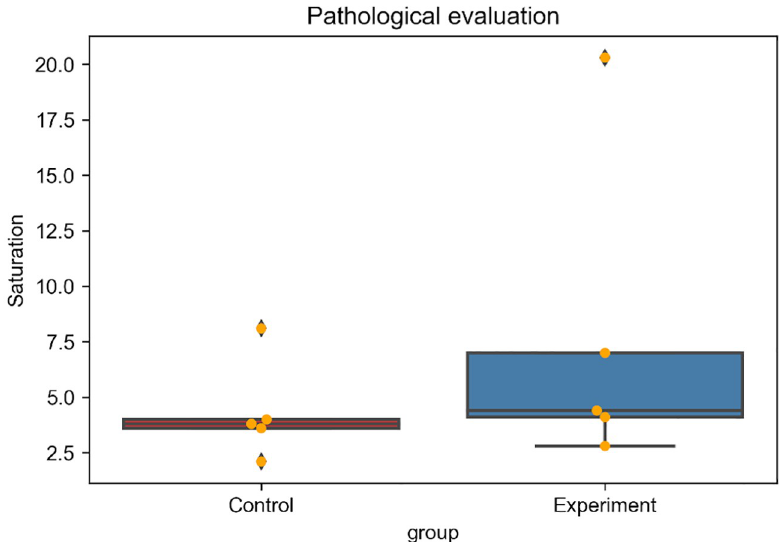
Fig 4. Quantitative pathological evaluation of Lipiodol accumulation in the tumors. The HSV model was used in the assessment. ‘Saturation’ values for areas with Lipiodol accumulation were evaluated using digitized specimens stained with Oil red O. Orange dot represents the value in each